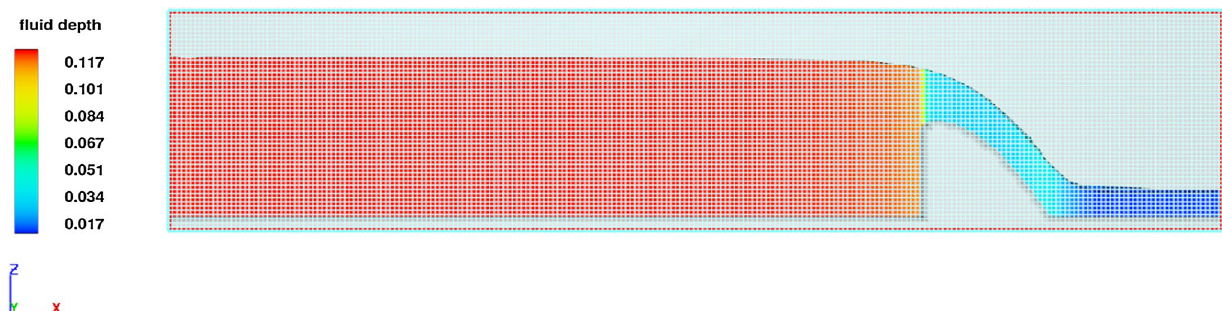
Fig. 11 General view of mesh Fig. 12 Boundary conditions and main